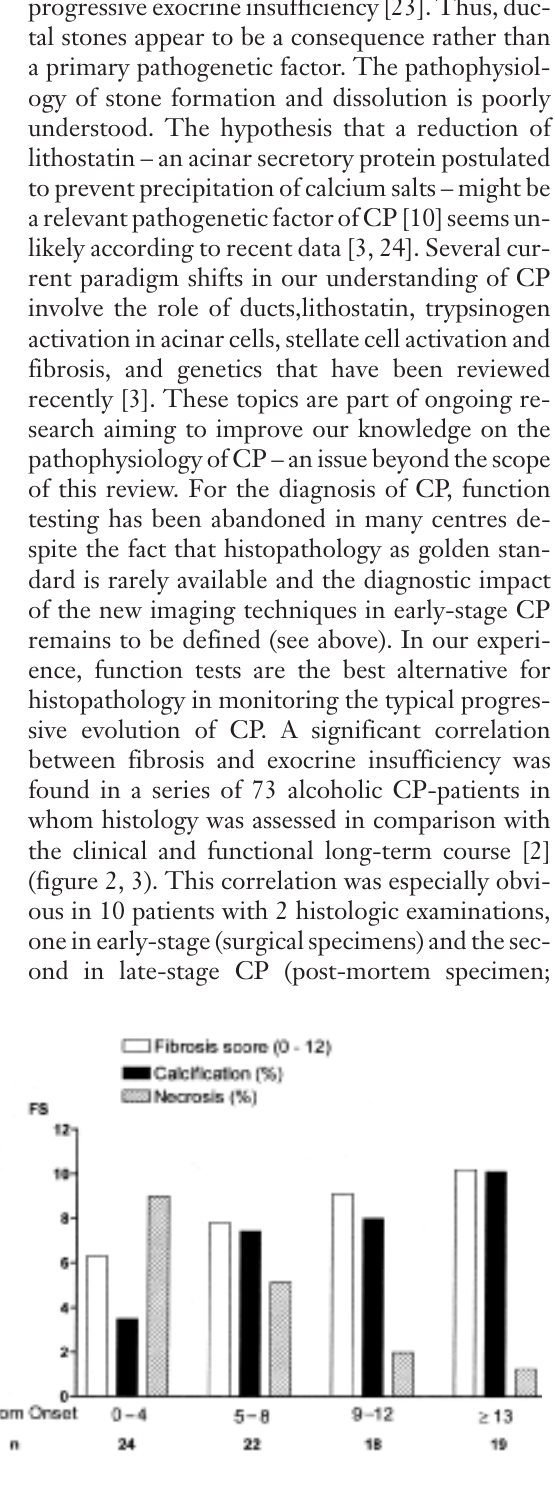
Evolution of progressive exocrine insufficiency and diabetes in relation to the fibrosis score (0–12) in the same series of alcoholic chronic pancreatitis (see fig. 2 and ref. [2]). A signifi- cant correlation is observed between fibrosis score (0–12) and exocrine insufficiency which indicates that function testing is the best surro- gate of histology in documenting progression to late-stage chronic pancreatitis. Onset of diabetes is typically delayed in comparison with exocrine insufficiency in alcoholic chronic